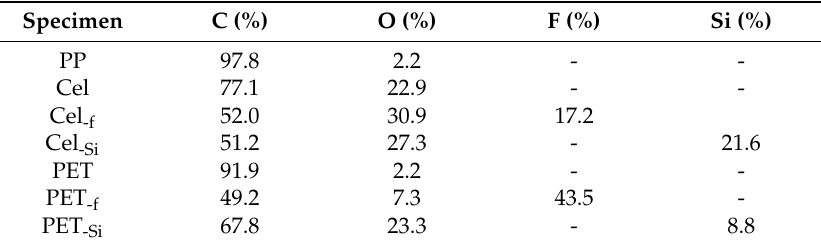
Table 5. XPS atomic concentration (%) of